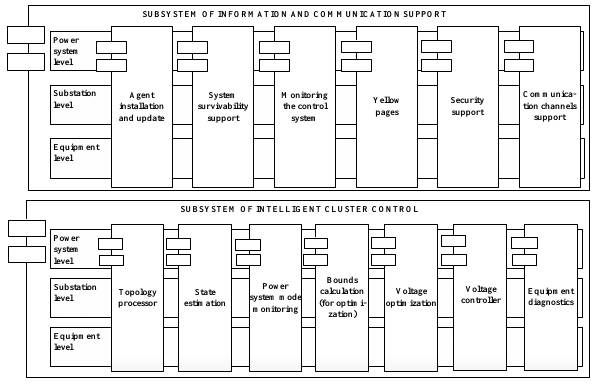
Figure 3. The block diagram of the multiagent automated system of voltage and reactive power